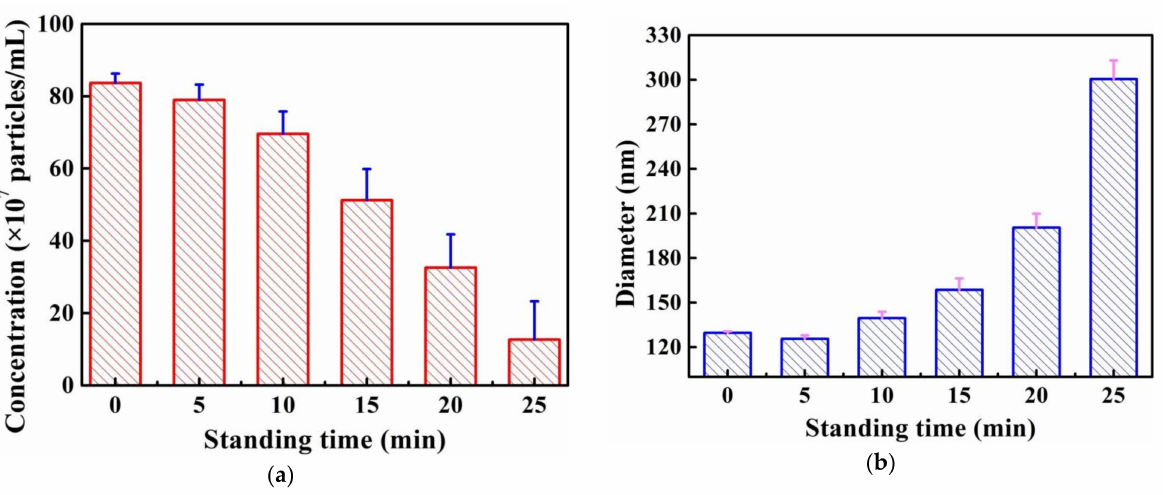
Figure 2. The relationship between the concentration ( a ) and diameter ( b ) of nanobubbles and the standing